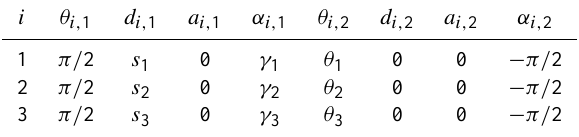
Table 1. D–H parameters for a 3-PRS PM when modelling the ma- nipulator with leg and platform as